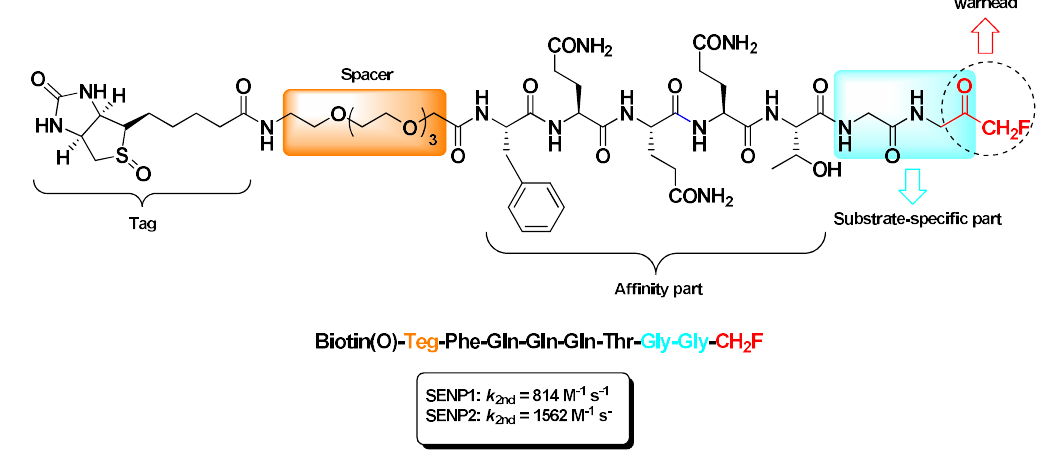
Figure 7. Chemical structure and biological activity of the biotinylated activity-based probe bearing a m-FMK C -terminal warhead developed by Funeriu’s research